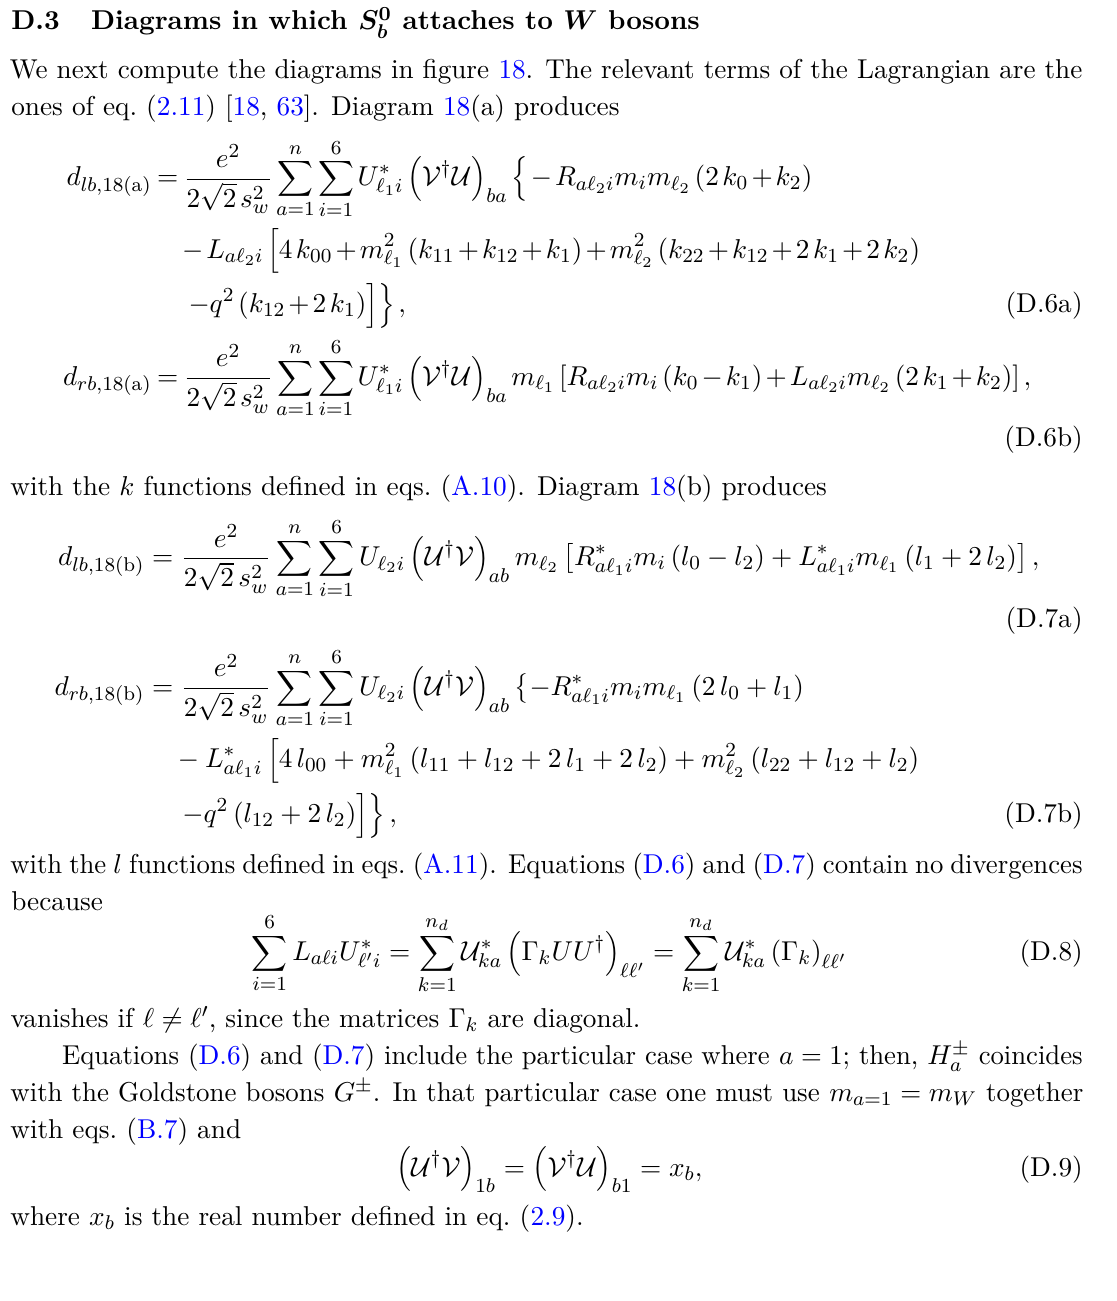
with the neutral scalar attaching to a gauge → ‘ + ‘ − 1 2 b